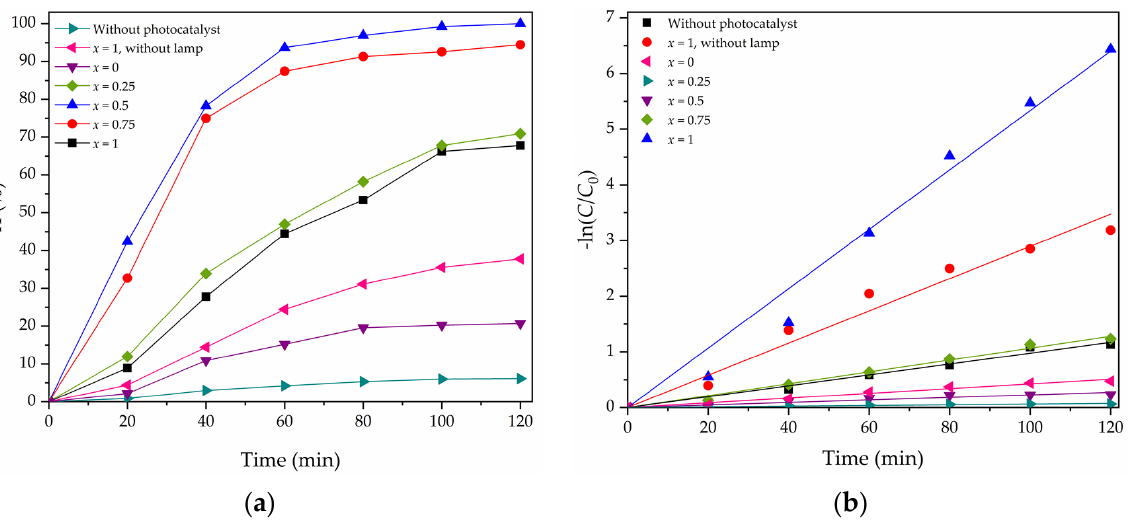
Figure 5. ( a ) Activity of perovskites Bi 2 W x Mo 1 − x O 6 in PODS and ( b ) pseudo-first-order kinetic fitting curves. Reaction conditions: 10 mL of model fuel, 200 ppm S, 0.1 g of photocatalyst, H 2 O 2 /DBT molar ratio of 10, 30 W LED lamp as the visible light source, and a distance of 10 cm from the light source to the model fuel.